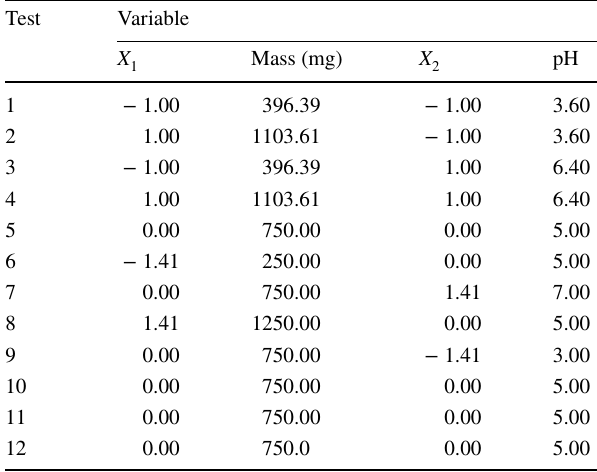
Table 1 Real and coded values for the planning of the central